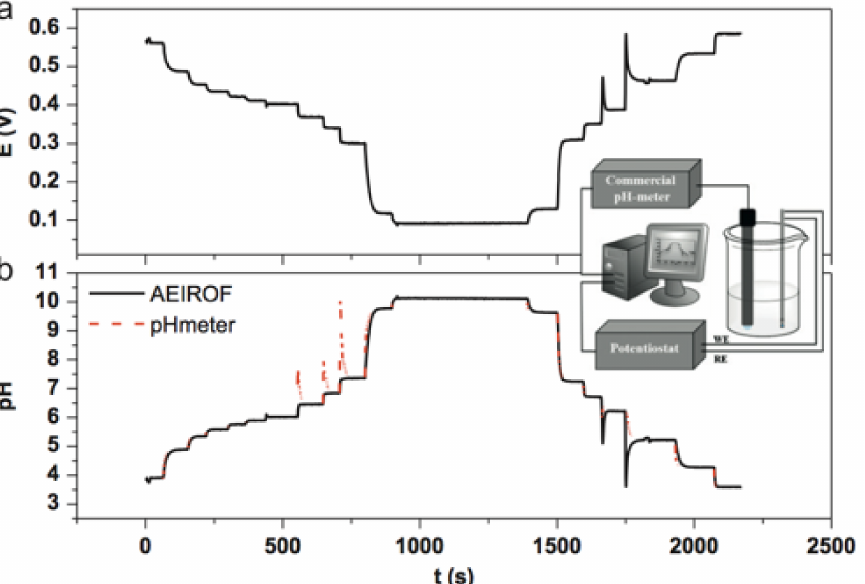
Figure 18. Response of AEIROF pH sensor ( a ) Change in the open circuit potential of the AEROF electrode over time when exposed to pH between 4 and 10. ( b ) Results were obtained for the AEIROF in terms of pH and those of a commercial pH meter. The insert illustrates the measurement set-up. The AEIROF pH sensor and a commercial pH meter were simultaneously immersed in a sample solution, and their response was registered in parallel while the solution pH was modified by drop- wise addition of either NaOH or HCl under stirring. Reprinted with permission from reference